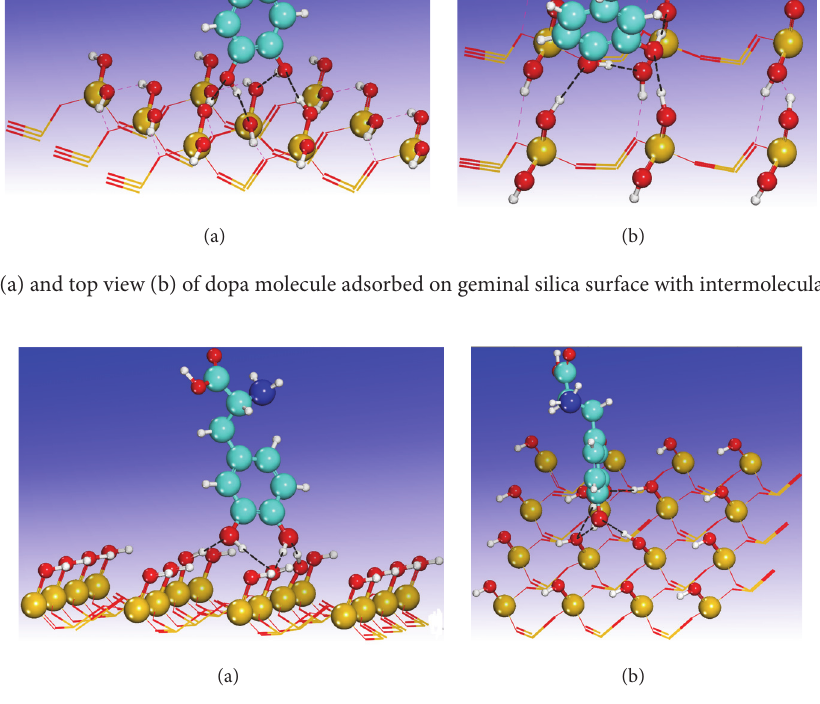
Figure 3: Side view (a) and top view (b) of L-dopa adsorption geometry on silica surface with intermolecular distances of 1.87 ˚A making four hydrogen bonds with terminal isolated silanols.